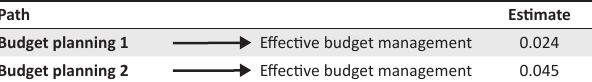
TABLE 12: Budget planning (Hypothesis 1).